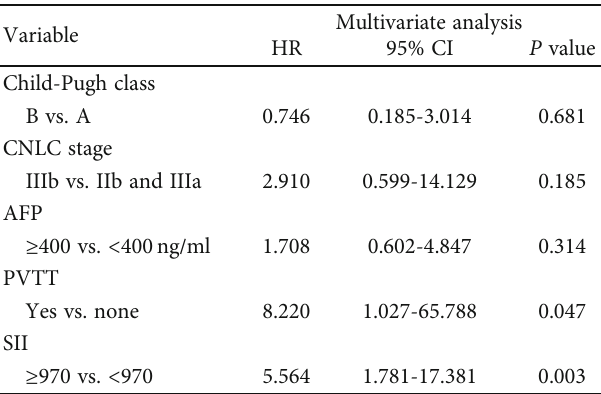
Table 6: Multivariate Cox proportional hazards regression models for overall survival.